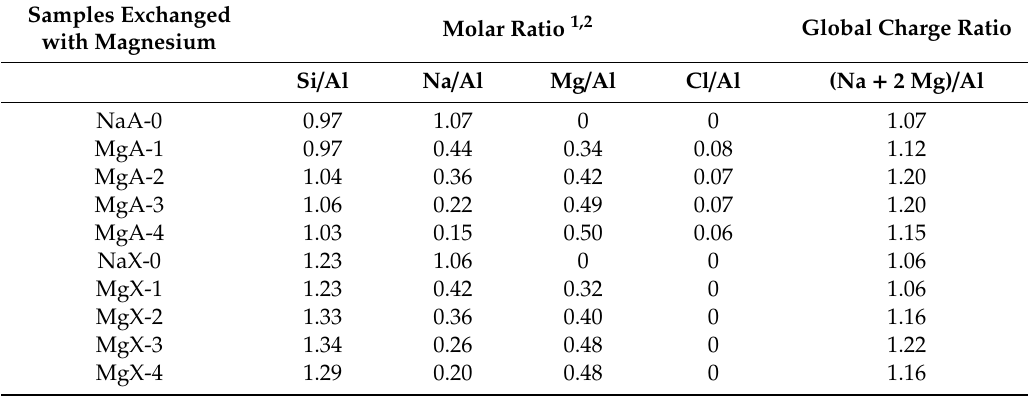
Table 1. Chemical composition of LTA-type and FAU-type zeolites and of their associated magnesium forms determined by XRF (Si / Al, Na / Al, Mg / Al and Cl / Al Molar